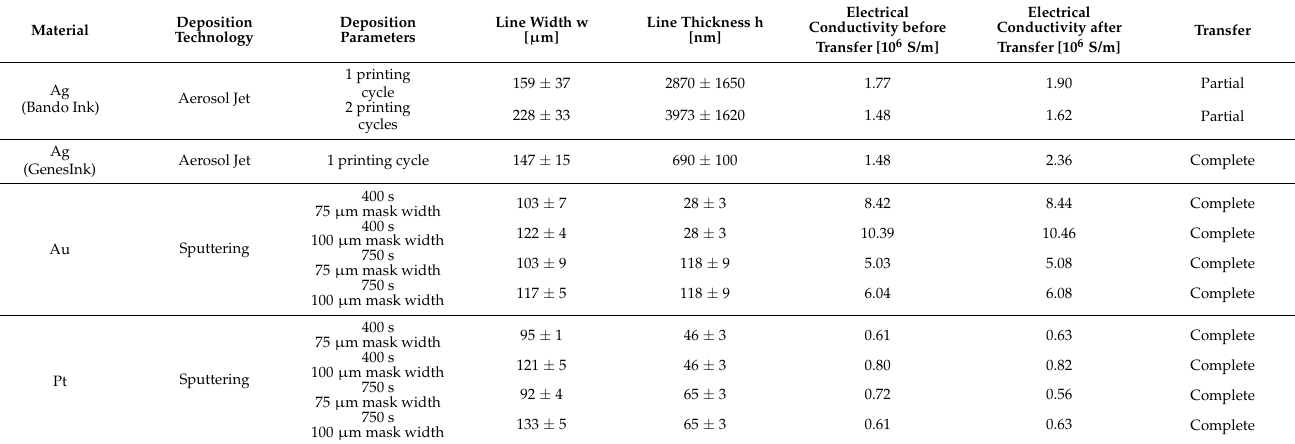
Table 2. Obtained dimensions, electrical conductivities before and after the transfer process, as well as transfer results for the different metals and deposition technologies. The values represent averaged results over three measurements each. The error given for the dimensions relates to the standard